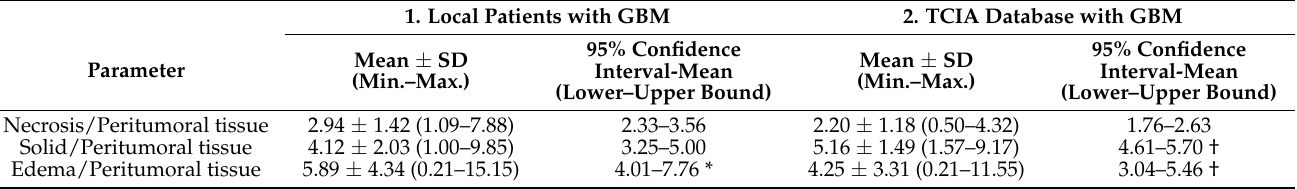
Table 3. Statistical peritumoral tissue comparisons between local patients with GBM and TCIA database as our validation cohort to carry out a pilot